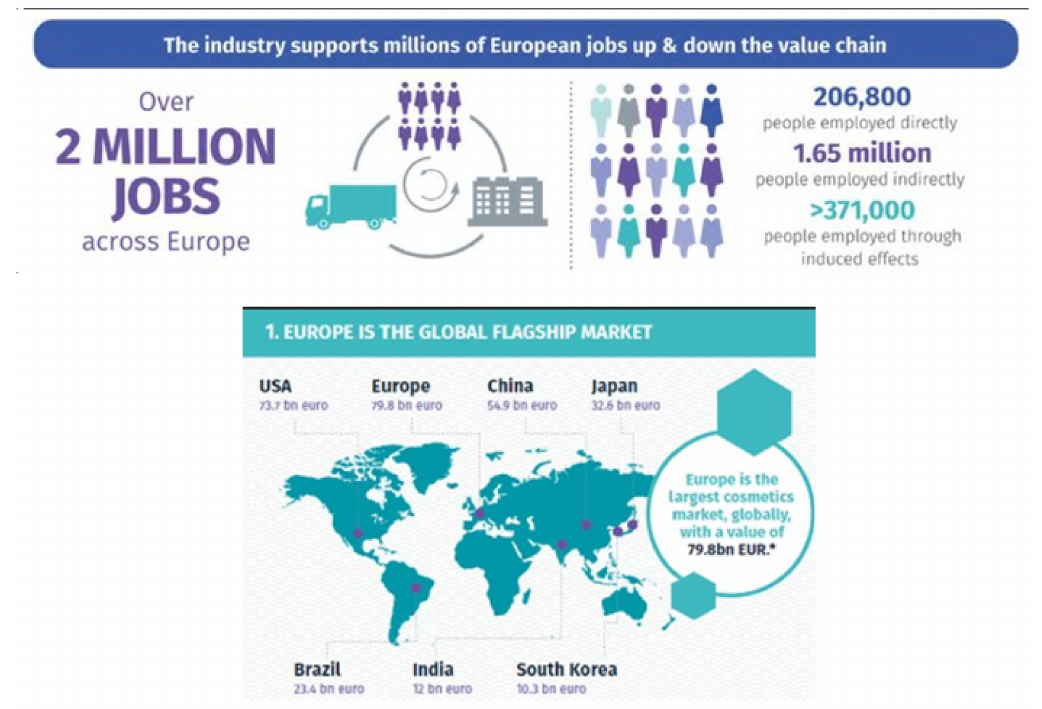
Figure 14. The EU jobs in 2019 involving cosmetics production and market (by the courtesy of Cosmetic Europe